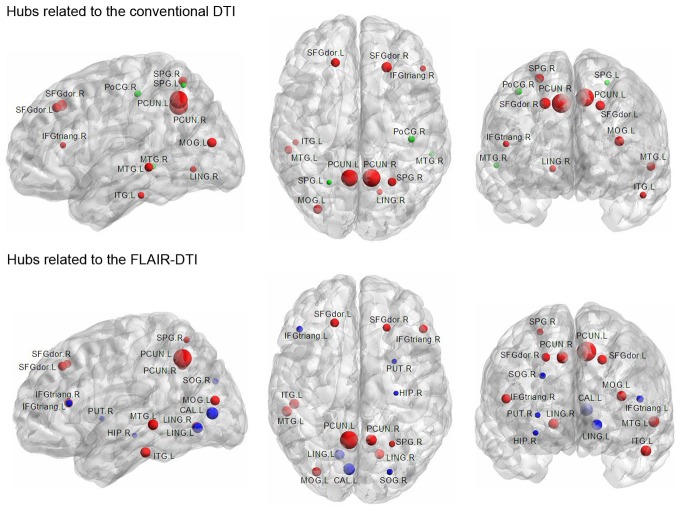
Rendering plot of the hub regions detected in the human brain anatomical networks for the conventional DTI (upper) and for the FLAIR-DTI (lower).Sixteen hub regions were identified in the anatomical network derived from the FLAIR-DTI datasets, whereas thirteen hub regions were derived in the network from the conventional DTI datasets. The size of the node represents the magnitude of the normalized betweenness centrality (see Table 3 for more details). Nodes in red represent hub regions shared by the networks derived from both types of DTI datasets. Nodes in green (blue) represent the hub regions specific to the network derived from the conventional DTI (FLAIR-DTI) datasets.